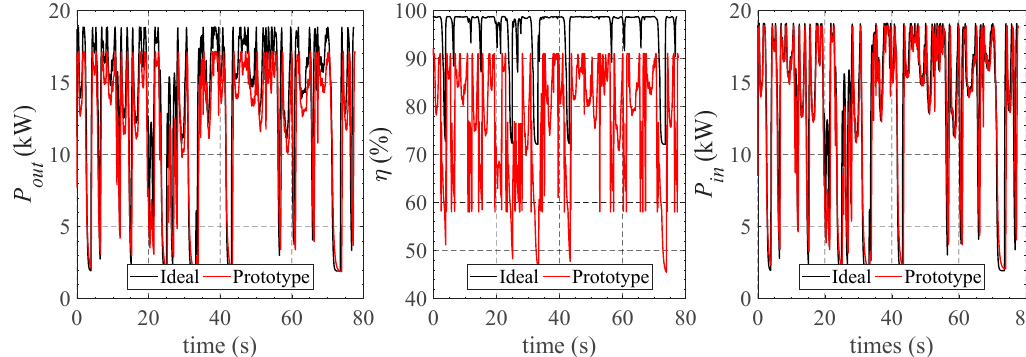
Figure 25. Motor output power, P out , efficiency, η , and input power, P in , along the FSAE Autocross Germany track for the ideal optimized motor and the prototyped motor.